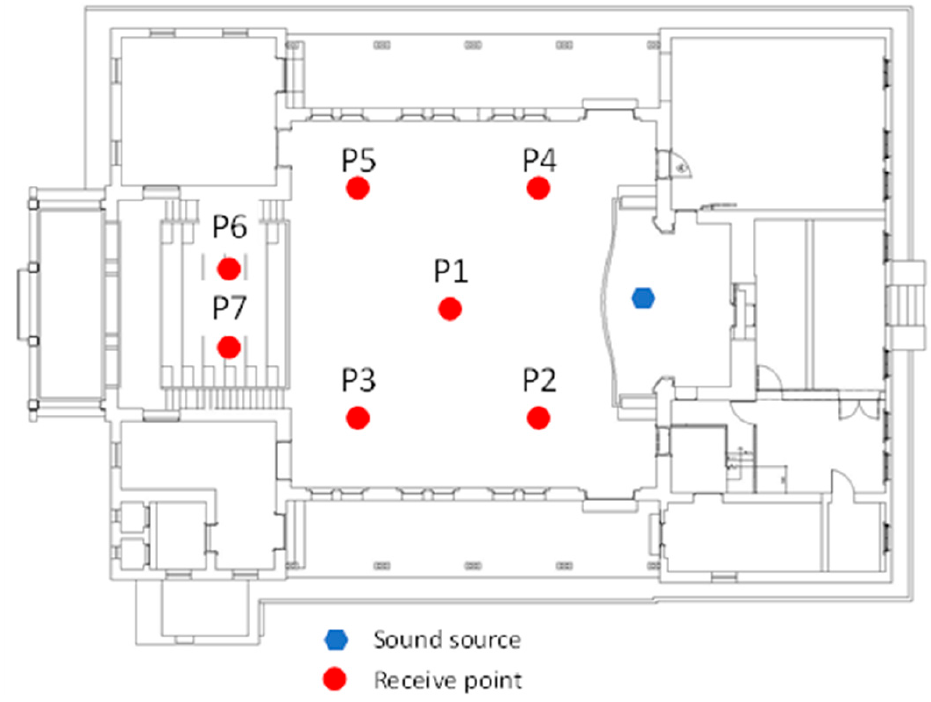
Figure 12. System of the field measurement.